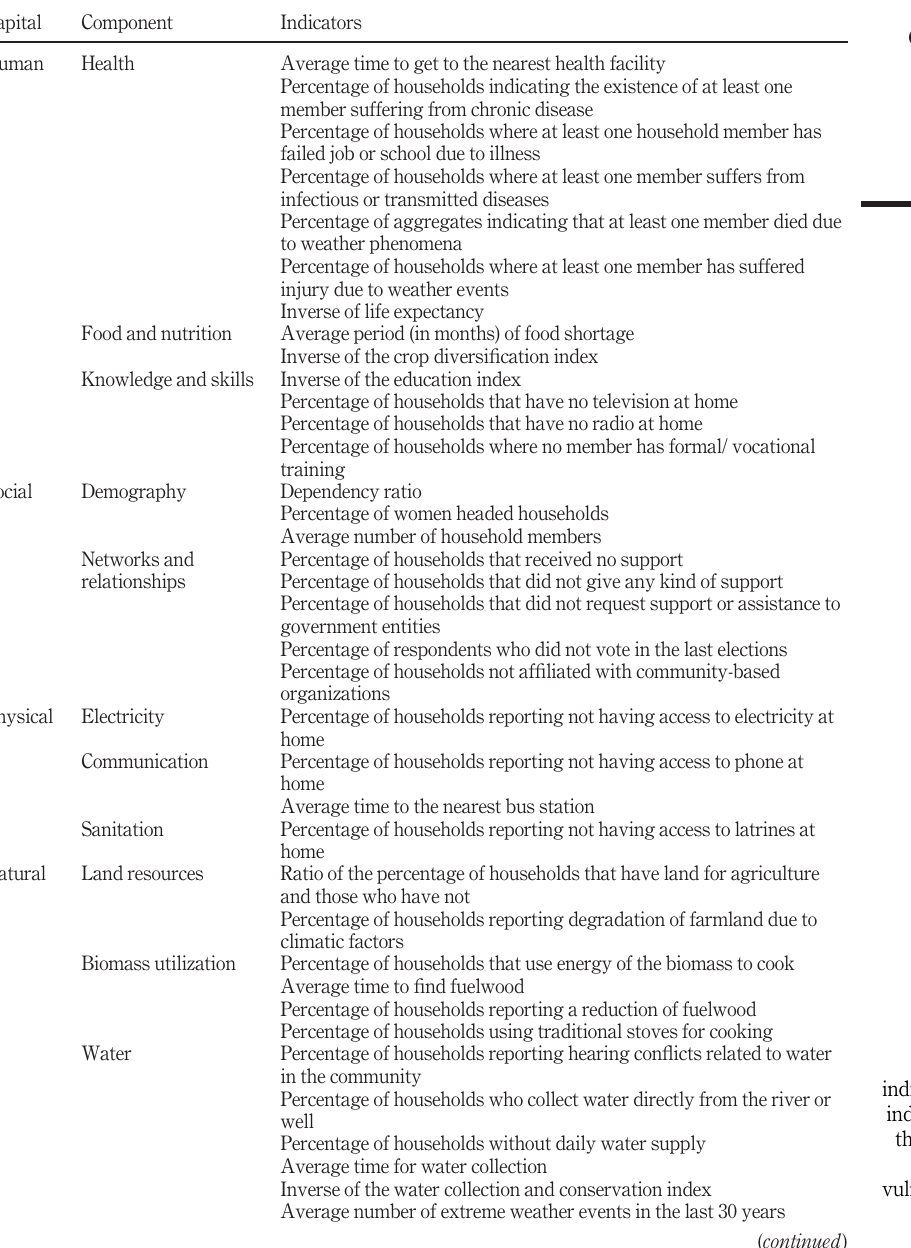
Table I. Capital system, indicators and sub- indicators used for the assessment of